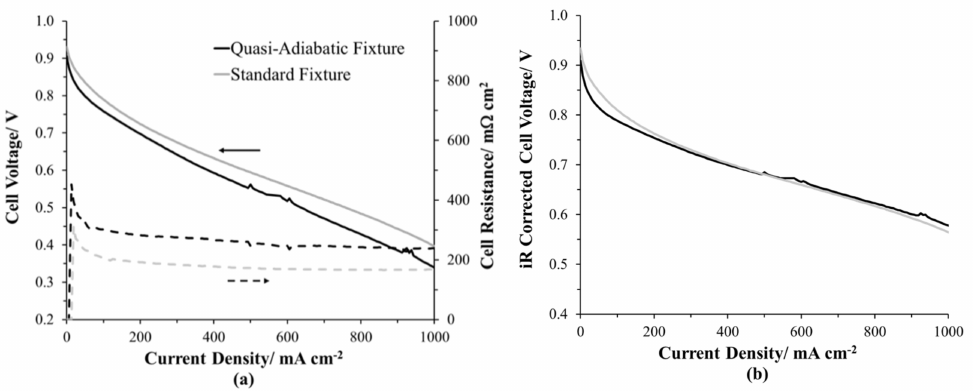
Figure 4. H 2 / 21% O 2 polarization curves at 80 ◦ C cell temperature and 44.3% relative humidity under ambient pressure for the quasi-adiabatic fixture and a standard fixture ( a ) cell voltage and ( b ) compensated iR free cell